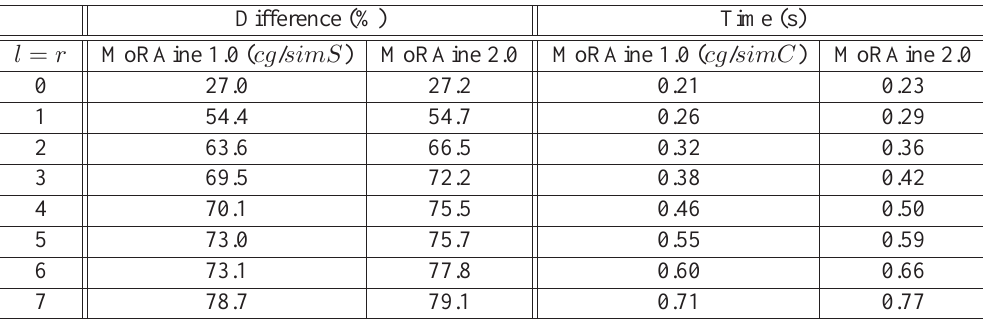
Table 2: In this table we compare the average information content improvement and the mean running time of MoRAine 1.0 with MoRAine 2.0 for different l - and r -values over all TFBSs of 85 transcriptional regulators of E. coli. We compare MoRAine 2.0 with the most accurate combination of similarity function and search method of MoRAine 1.0 (left side) and with the fastest combination (right